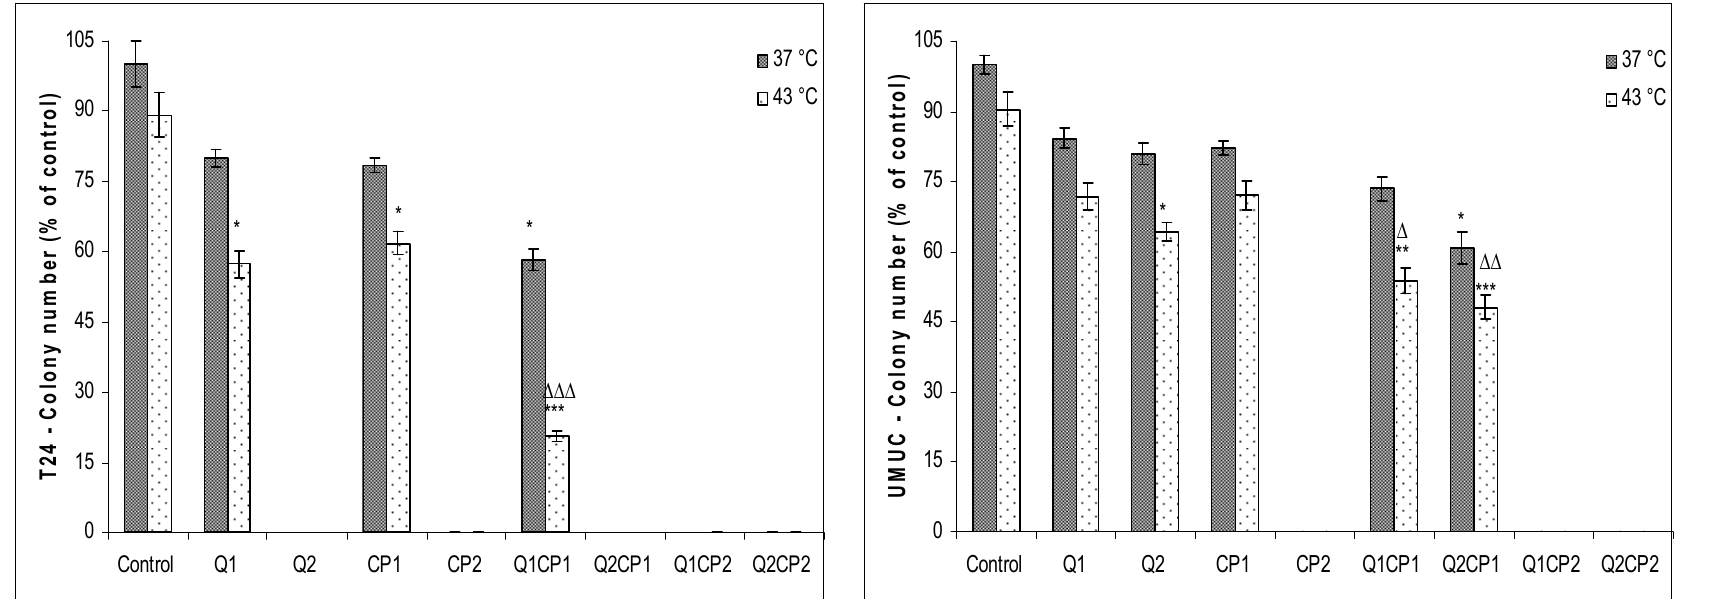
Figure 2. Colony formation e ffi ciency of quercetin (QU), cisplatin (CP) and their combinations in T24 and UMUC human bladder cancer cells under physiological and hyperthermic conditions. T24 and UMUC cells were preincubated with 1 or 50 µ M QU for 2 h at 37 ◦ C, washed with phosphate-bu ff ered saline (PBS) and incubated in fresh medium with or without 1 or 50 µ M CP for 1 h under physiological and hyperthermic conditions. Following treatment with CP, cells were rinsed again with PBS for three times to remove the CP and afterwards were grown in incubator for up to 14 days in complete culture media. After 14 days, colonies were fixed with 100% methanol, stained with Giemsa stain and the plating e ffi ciency (PE) was calculated as PE = (Colonies formed / Cells seeded) × 100%. The data are expressed as mean ± SD of colony formation e ffi ciency in comparison to control from three independently performed experiments. * Significantly di ff erent (* p < 0.05; ** p < 0.01; *** p < 0.01, nonparametric Kruskal-Wallis test) from control group at 37 ◦ C. ∆ Significantly di ff erent ( ∆ p < 0.05; ∆∆ p < 0.01; ∆∆∆ p < 0.001, nonparametric Kruskal-Wallis test) from control group at 43 ◦ C. Abbreviations: QU1 or QU2, treatments with quercetin at concentrations of 1 or 50 µ M; CP1 or CP2, treatments with cisplatin at concentrations of 1 or 50 µ M.